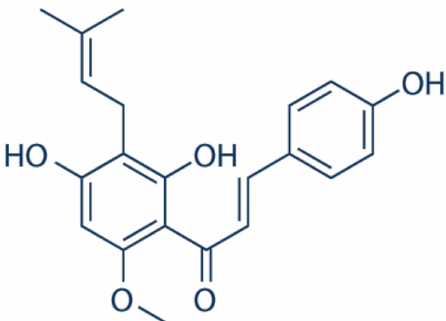
Figure 18. The chemical structure of xanthohumol.